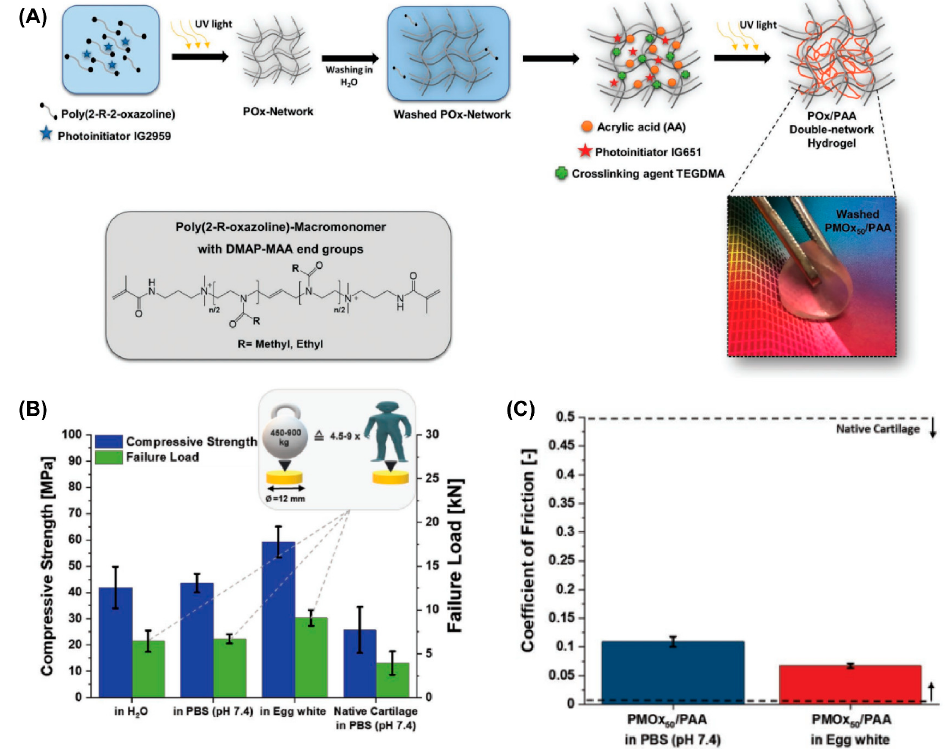
Figure 7. ( A ) Steps in the synthesis of POx/PAA double-network hydrogels. ( B ) Compressive strength and failure load of AC and POx/PAA hydrogels in PBS (pH 7.4). ( C ) The friction coefficient of POx/PAA hydrogels lubricated by PBS (pH 7.4) and egg white. Reprinted with permission from Ref [75]. Copyright 2022, John Wiley and Sons.